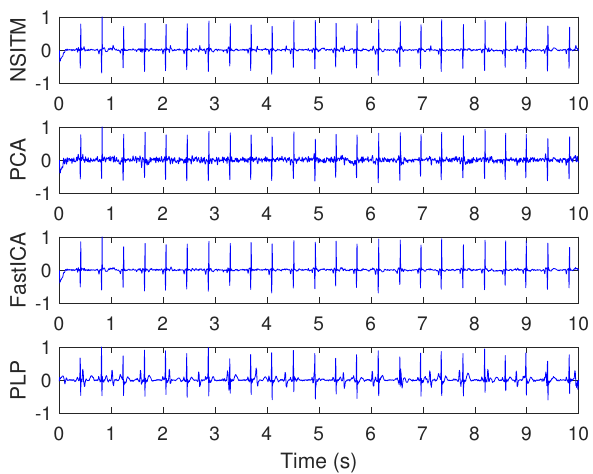
Figure 15. Extracted FECG signals using NSITM, PCA, and FastICA algorithms, using data shown in Figures 13 and 14. The y -axis labels refer to the names of the algorithms used for extracting the FECG signals.